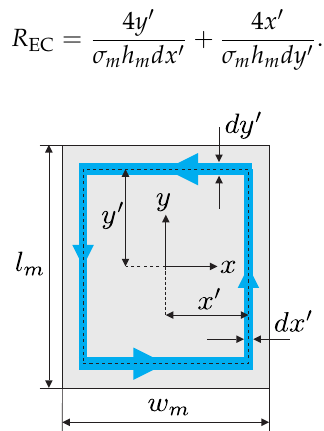
Figure 2. Assumed eddy-current paths adopted in Model A (redrawn from